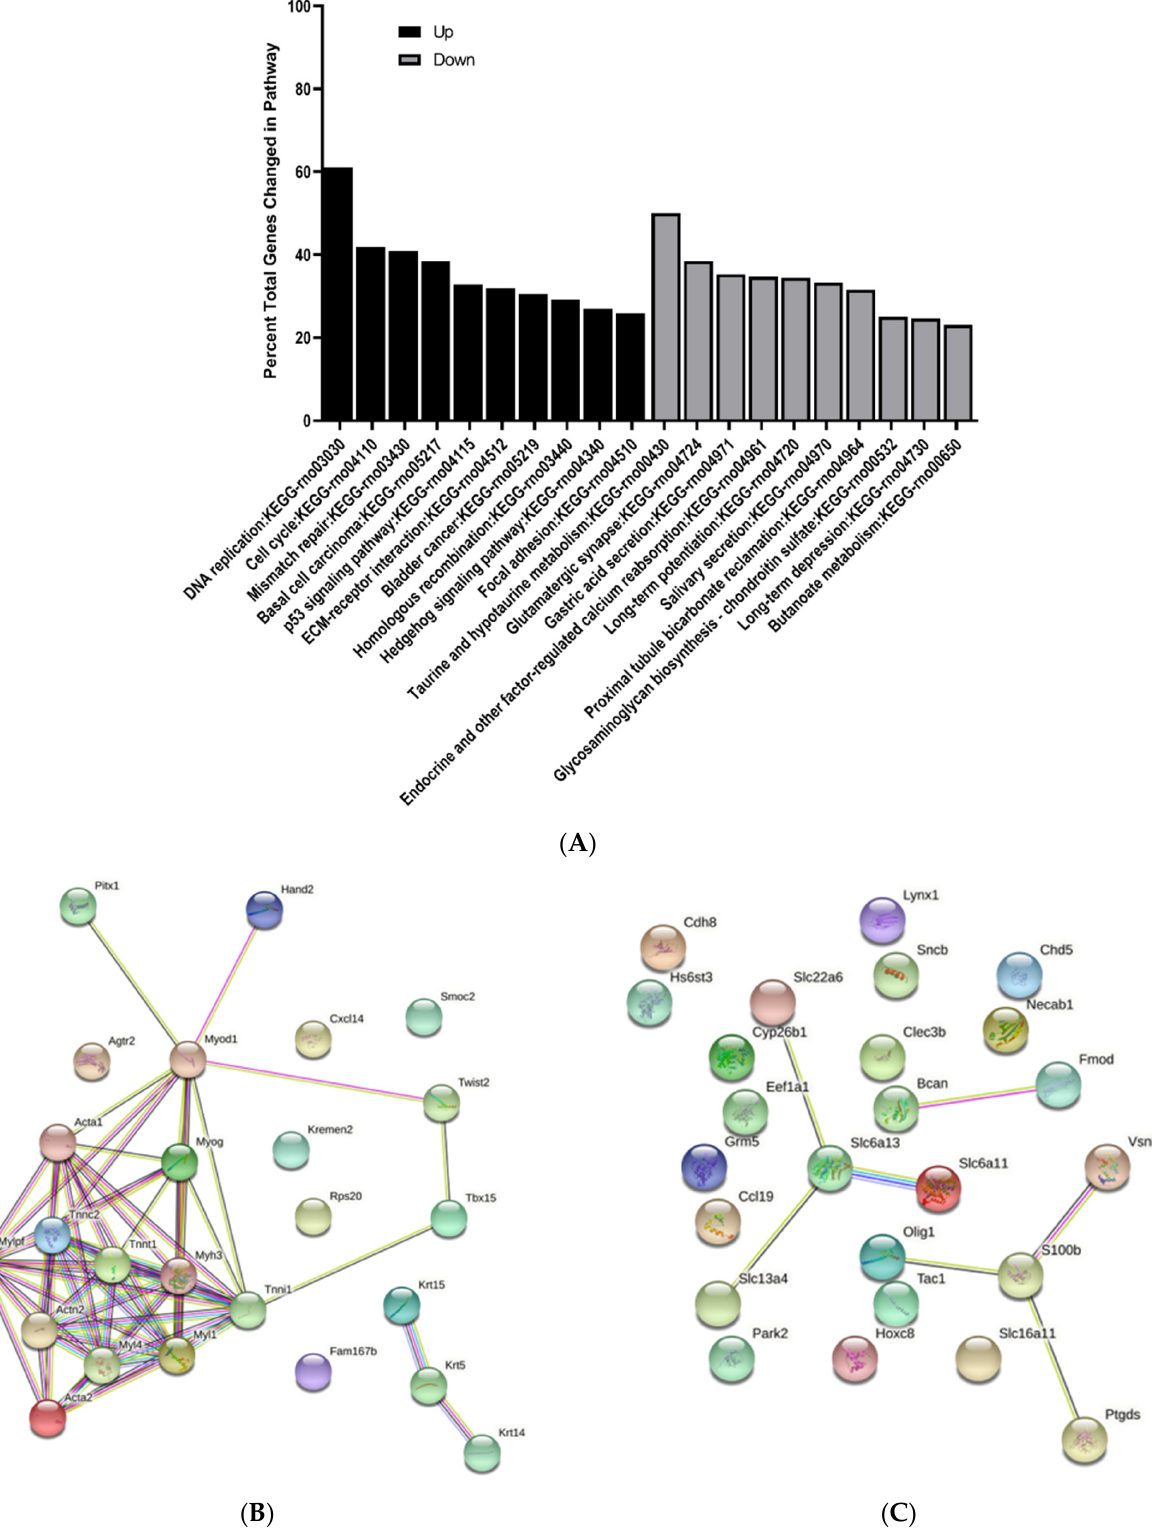
Figure 9. KEGG and protein–protein interaction network analysis of differentially expressed genes in the spinal cord of MMC and vehicle fetuses isolated at E15. ( A ) Top 10 KEGG pathways upregulated and downregulated as determined by percent total changed genes in each pathway. All pathways were greater than 1.5-fold change and p < 0.05. ( B , C ) Protein–protein interaction network analysis based on top 25 ( B ) upregulated and ( C ) downregulated differentially expressed genes.